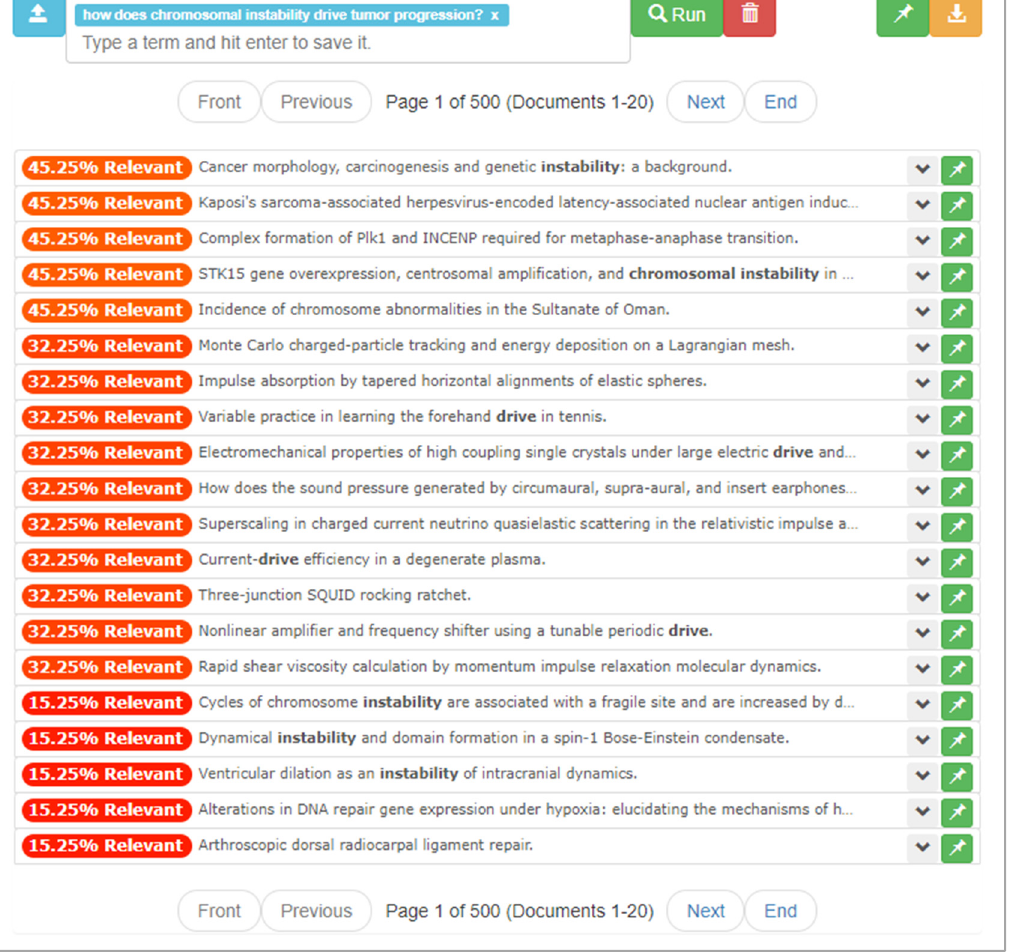
Figure 9. The results of a search task using the query, “How does chromosomal instability drive tumor progression?”